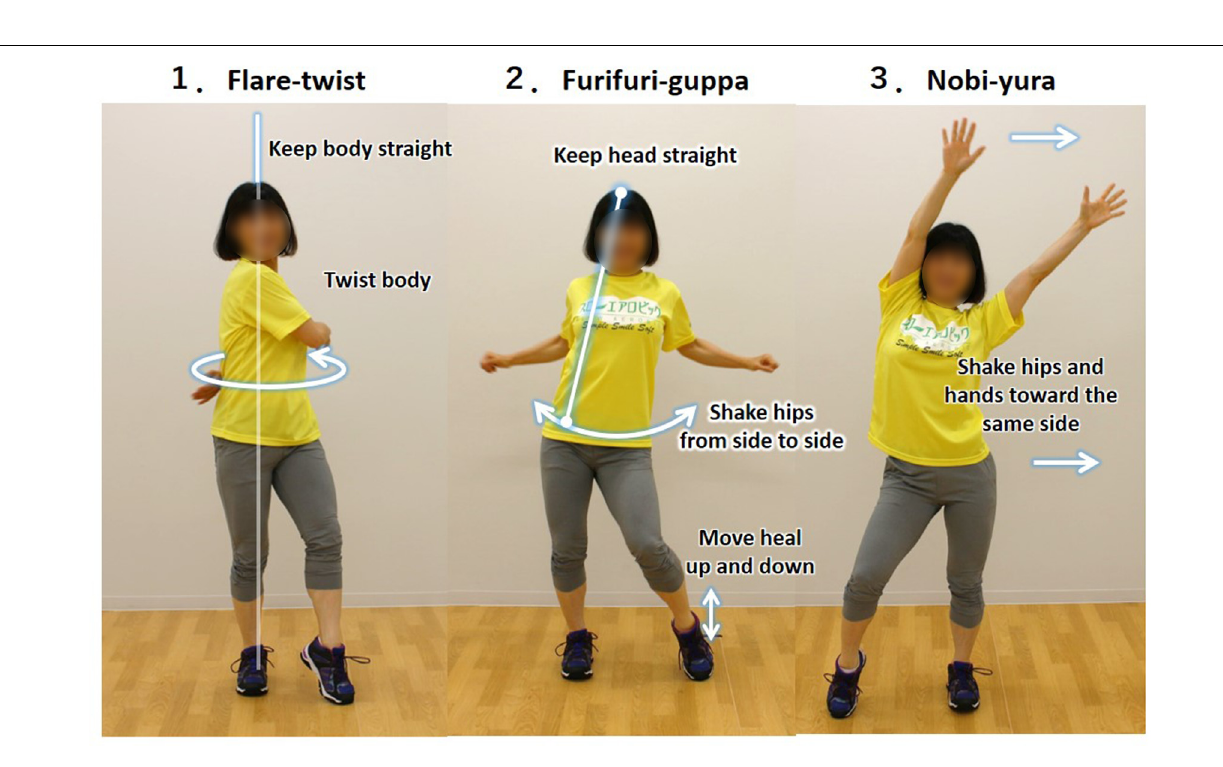
states (i.e., energetic, lively, lethargic, listless, relaxed, calm, irritated, and nervous). Participants scored each item using a 6-point rating scale ranging from 0 (not at all) to 5